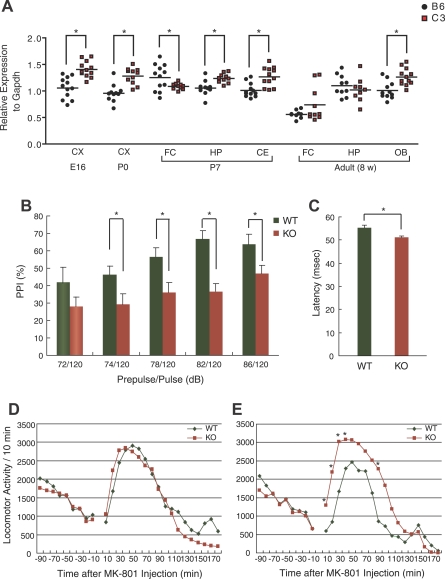
Analyses of Fabp7 Expression and Knockout Mouse Behavior(A) Relative expression levels of Fabp7 at different developmental stages and anatomical regions in B6 and C3 mice. The adult stage mice were all males. CX, cerebral cortex; HP, hippocampus; CE, cerebellum; FC, frontal cortex; OB, olfactory bulb, *p < 0.05(B) PPI (%) between wild-type (WT, n = 9: six males and three females) and Fabp7 (–/–) mice (KO, n = 12: six males and six females). The values represent mean ± s.e. *p < 0.05.(C) Latency between male wild-type (WT, n = 9: six males and three females) and Fabp7 (–/–) mice (KO, n = 12: six males and six females). The values represent mean ± s.e. *p < 0.05.(D) Locomotor responses after a single injection of MK-801 in male wild-type (WT, n = 6) and Fabp7 (–/–) mice (KO, n = 6).(E) Locomotor responses after a challenge injection of MK-801, following five repeated pre-treatments, in male wild-type (WT, n = 6) and Fabp7 (–/–) mice (KO, n = 6). The genotype effect was significant [F(1,5) = 5.18, p < 0.05]. *p < 0.05 after post hoc analysis.